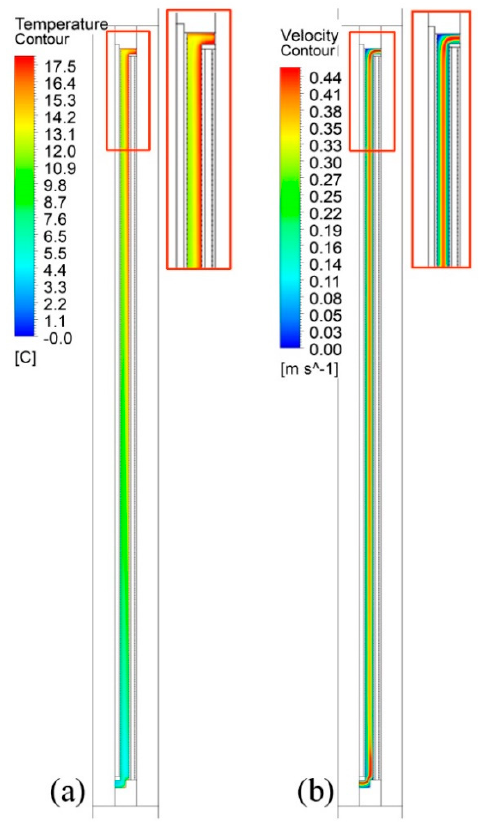
Figure 7. a : Temperature distribution; b: velocity contours within the cavity. Figure 7. ( a ): Temperature distribution; ( b ): velocity contours within the